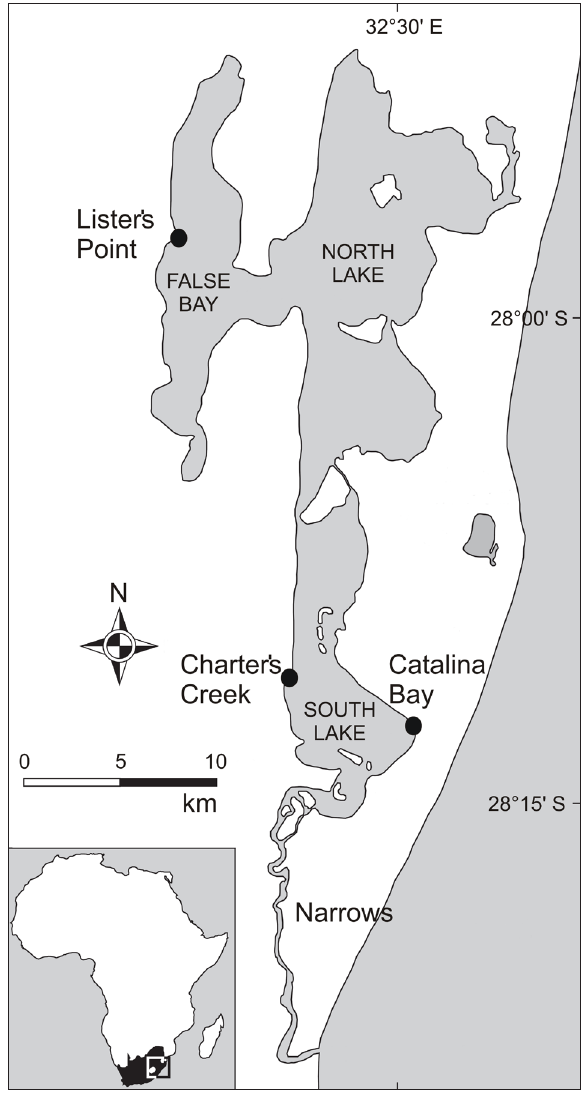
Figure 1: Map of Lake St Lucia. Black dots indicate dedicated sampling